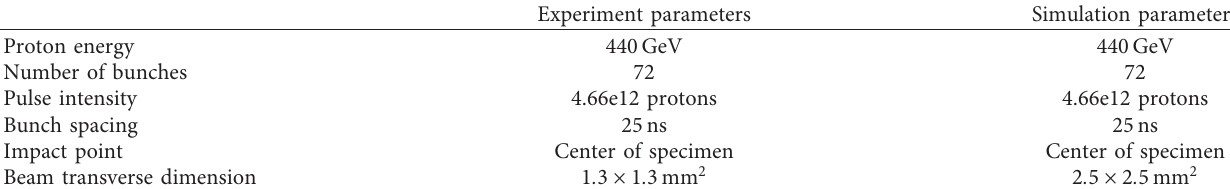
Table 8: Beam parameters, medium-intensity tests on Glidcop ® .